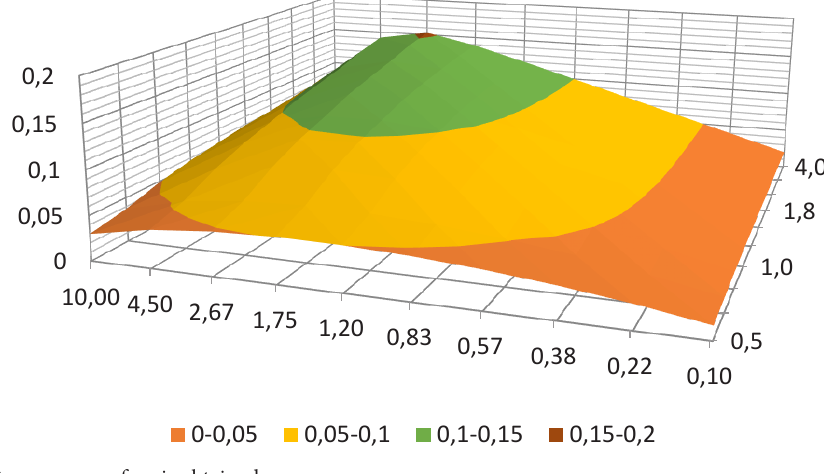
Figure 4. Dependence on elasticity and labor/capital intensity a b for cases when 3 w k = and 1 3 w k